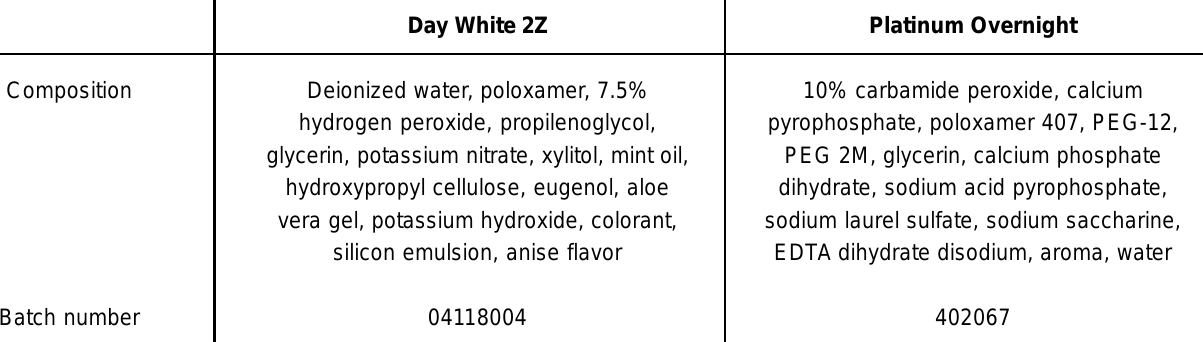
FIGURE 1- Basic composition and manufacturer of each bleaching